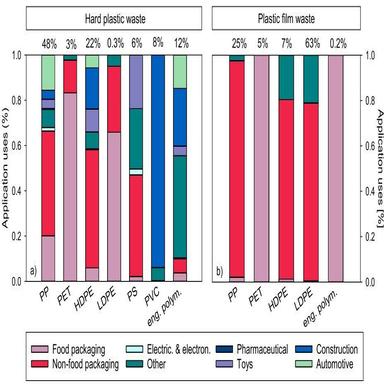
Application uses (%, on a wet weight basis) of each polymer in (a) hard plastic waste and (b) plastic film waste (average over the three recycling centres). Percentages above the polymer bars represent the overall polymer composition (average over the three recycling centres). Electric. & electron.: electrical and electronic equipment; eng. polym.: engineered polymers. For detailed results please refer to Appendix E.